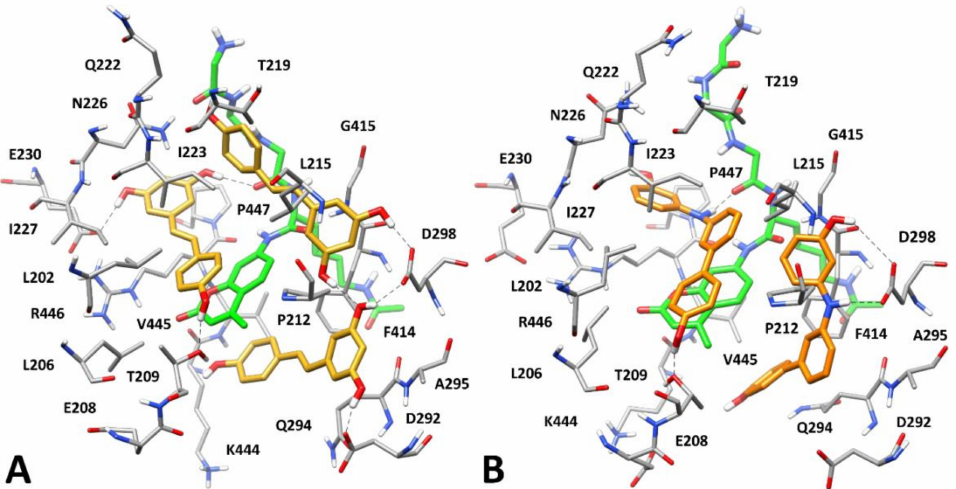
Figure 4. ( A ) Minimized average structure of SIRT1 in complex with p53-AMC peptide (green) and three molecules of resveratrol (gold). ( B ) Minimized average structure of SIRT1 in complex with p53-AMC peptide and two molecules of 10 (orange). In both panels, ligand–protein and ligand–peptide H-bonds are highlighted as black dashed lines. For clarity, the side chains of R1, H2 and K3 of the p53-AMC peptide are not